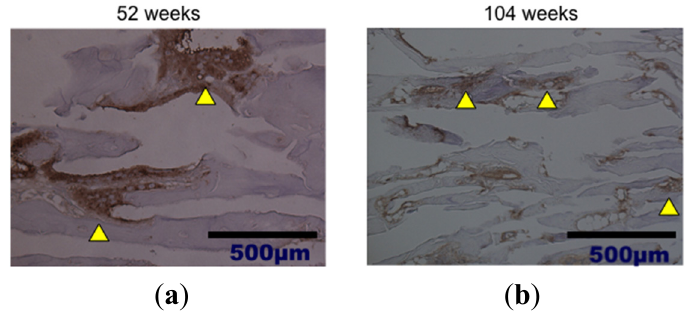
Figure 5. Histological findings of decalcified UDPHAp specimens by osteocalcin immunostaining at 52 weeks ( a ) and 104 weeks ( b ) after transplantation. Cells lined below formed bone (yellow arrow head) are positively stained.